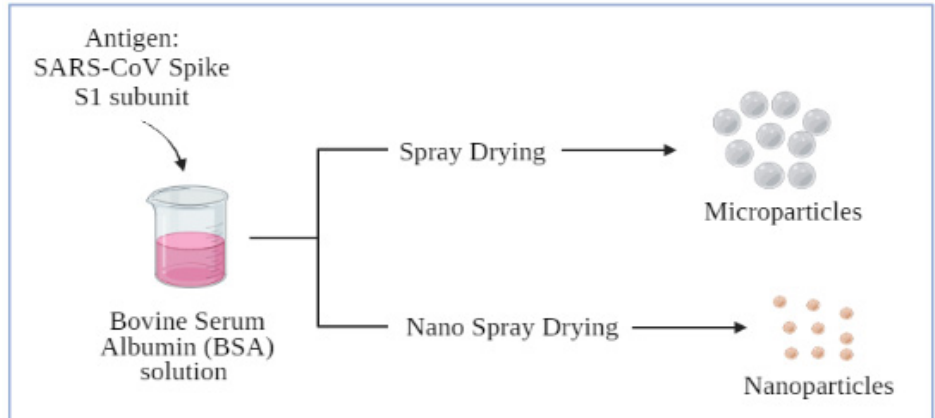
Figure 3. Formulation of microparticles or nanoparticles using spray drying method .